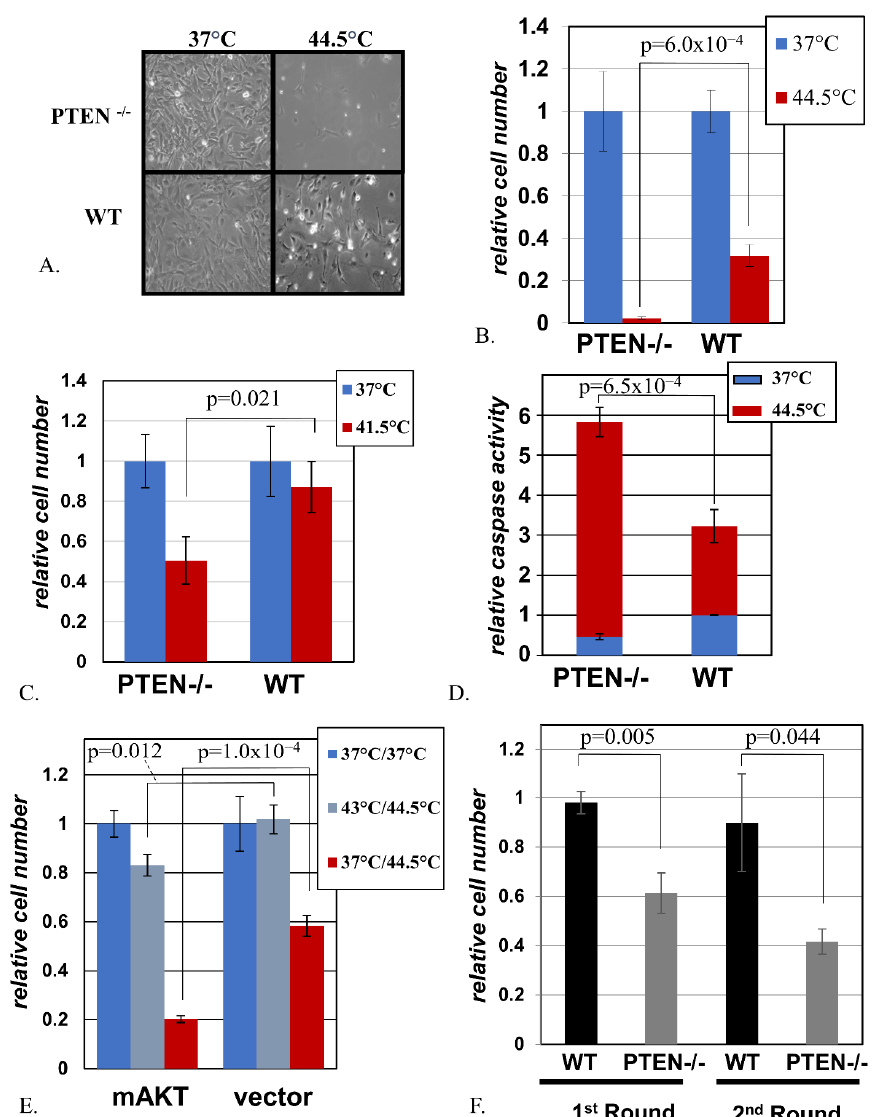
Figure 2. The loss of PTEN and activation of AKT enhance sensitivity to hyperthermia. ( A ). MEF PTEN-/- and MEF WT were exposed to the indicated temperatures for 30 min, allowed to recover in normal growth conditions for 24 h, and photographed. ( B ). The number or remaining MEF PTEN-/- and MEF WT cells treated as in A was compared 48 h after the heat shock. The data from triplicate experiments for each cell line are shown normalized to the average values in the respective control (37 ◦ C) populations. ( C ). MEF PTEN-/- and MEF WT were exposed to the indicated temperatures for 2 h and then analyzed as in B after recovering for 48 h. The data from triplicate experiments for each cell line are shown normalized to the average values in the respective control (37 ◦ C) populations. ( D ). The activity of caspase 3 was measured in MEF PTEN-/- and MEF WT cell populations treated as in A. The data from triplicate experiments for each cell line are shown normalized to the average values in the control (37 ◦ C) populations of MEF WT. ( E ). MEF-AG harboring either mAKT or the respective empty vector (EV) were subjected to a pre-treatment at either 43 ◦ C or 37 ◦ C for 30 min, followed 5 h later by a 30 min heat shock at 44.5 ◦ C. Then, 48 h later, the numbers of remaining cells were scored. For each cell line, the values from triplicate experiments are plotted relative to those of the respective control populations grown without hyperthermia (“37 ◦ C/37 ◦ C”). ( F ). Triplicate cultures of MEF PTEN-/- and MEF WT were heat-shocked at 41.5 ◦ C for 2 h and, 48 h later, the remaining cells were scored (“1st round”). A parallel set of three heat-shocked cultures of each cell line was allowed to recover under normal culture conditions. A week later, the recovered cells were subjected to a repeat of the heat shock treatment, and the remaining cells were scored 48 h later (“2nd round”). For each cell variant, the data on the remaining cells from triplicate cultures after each round of treatment are shown after normalization to the average values from their respective control populations (also triplicates) grown at 37 ◦